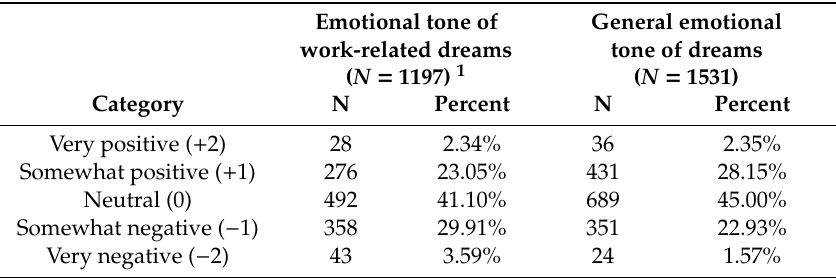
Table 2. Overall emotional tone of work-related dreams and the general emotional tone of